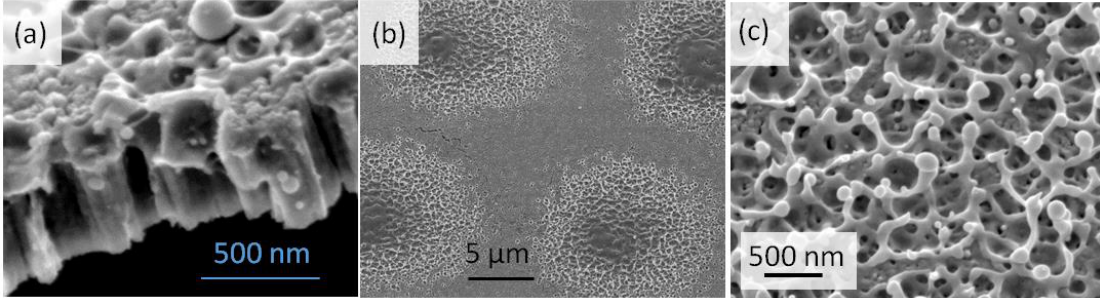
Figure 1. SEM images of the structured Au film: ( a ) side, and ( b ) and ( c ) top view at different